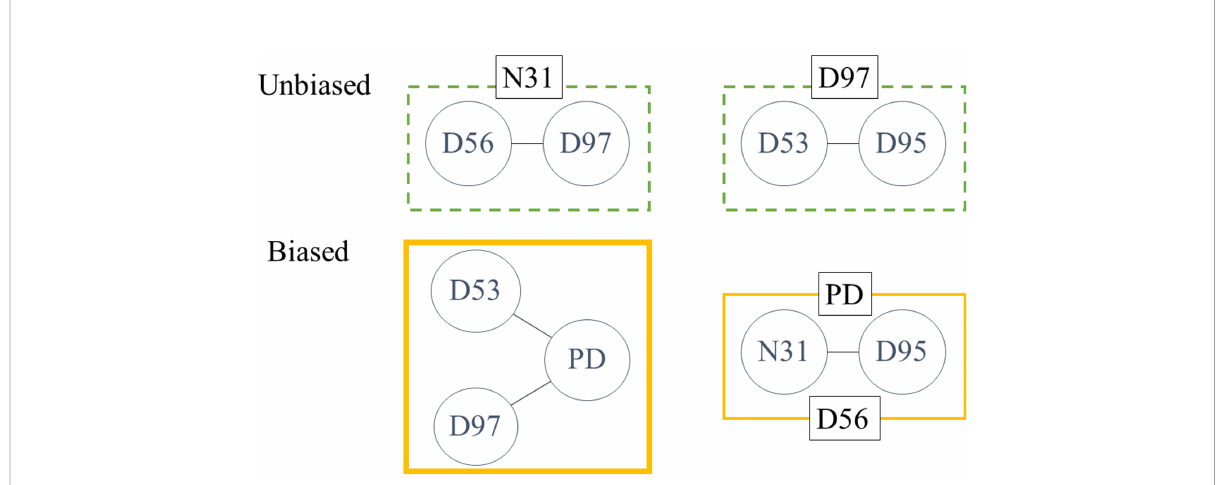
FIGURE 5 Correlated AAs in both samples. Within six subgroups of both unbiased and biased BCRs classi fi ed using one of the contact residues (N31, D53, D56, D95, D97, and PD), correlations among other contact residues were calculated by Pearson ’ s correlation. Two correlations were detected in subgroups containing either N31 or D97 in unbiased BCRs. In biased BCRs, D53 and D97 were correlated to PD when the subgroup was chosen by the other residue. The correlation between N31 and D95 was seen in both PD and D56 subgroups. Amino acids are annotated by Kabat numbering.